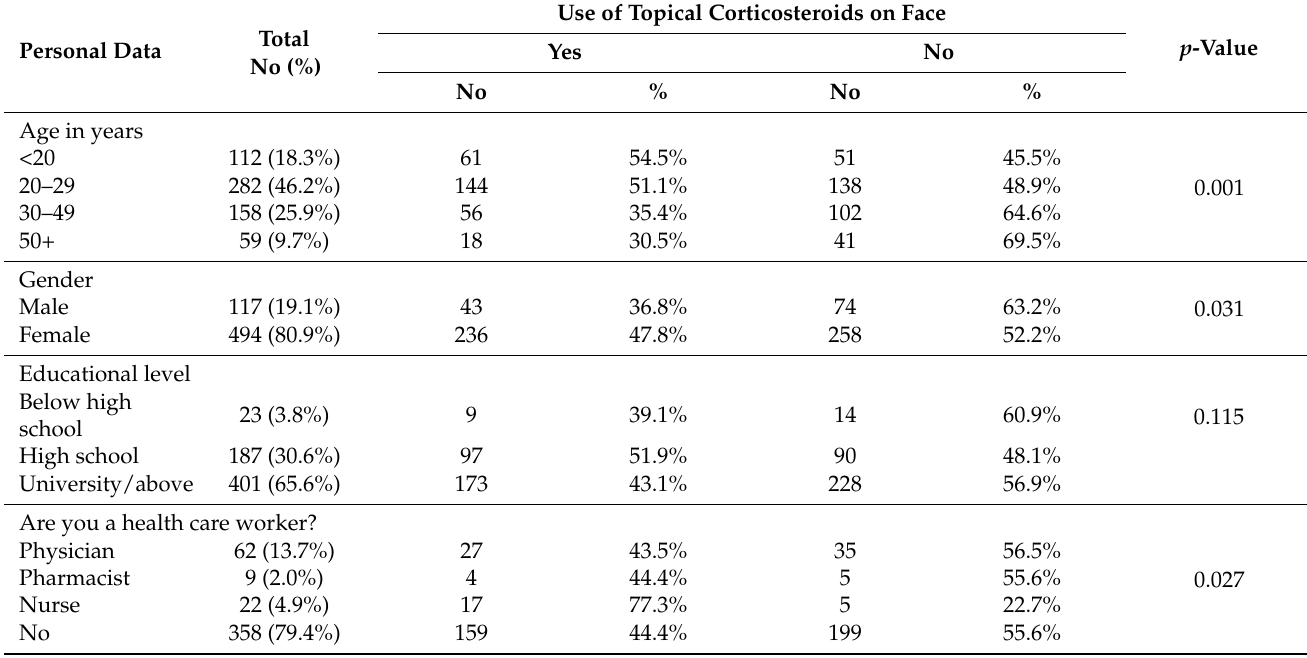
Table 4. Distribution of participants use of topical facial corticosteroids by their personal